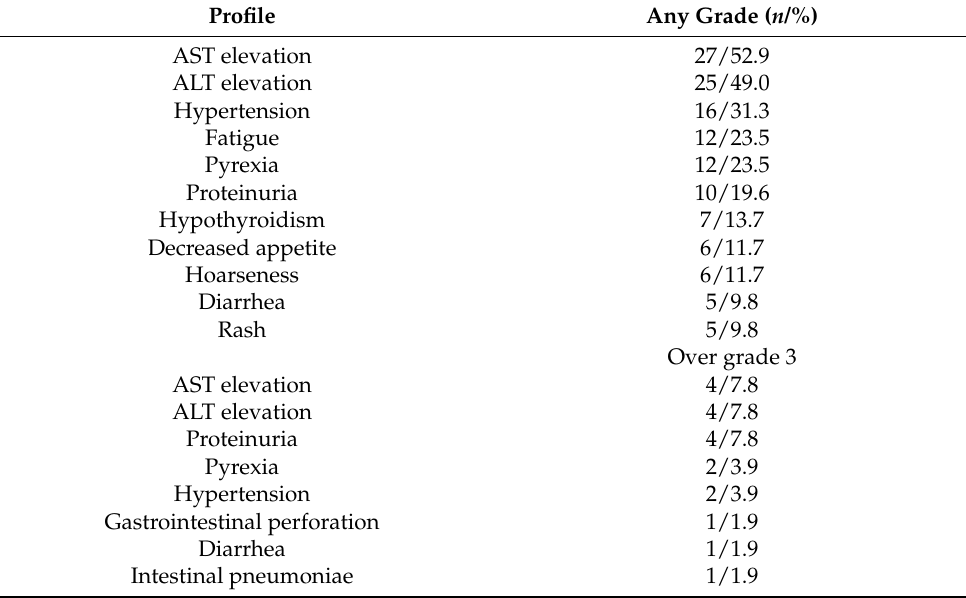
Table 2. Profile of adverse events in atezolizumab plus bevacizumab.